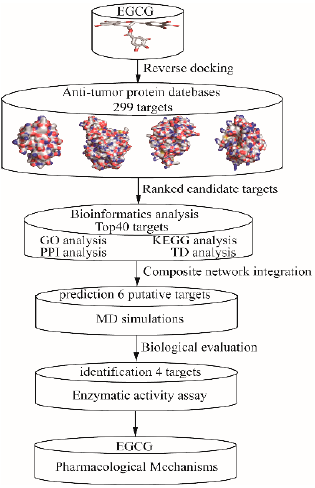
Figure 1. The schematic representation of the epigallocatechin gallate (EGCG) anti-tumor mechanisms. GO, KEGG, PPI, TP and MD presented gene ontology, Kyoto encyclopedia of genes and genomes, protein–protein interaction, target–pathway and molecular dynamics.